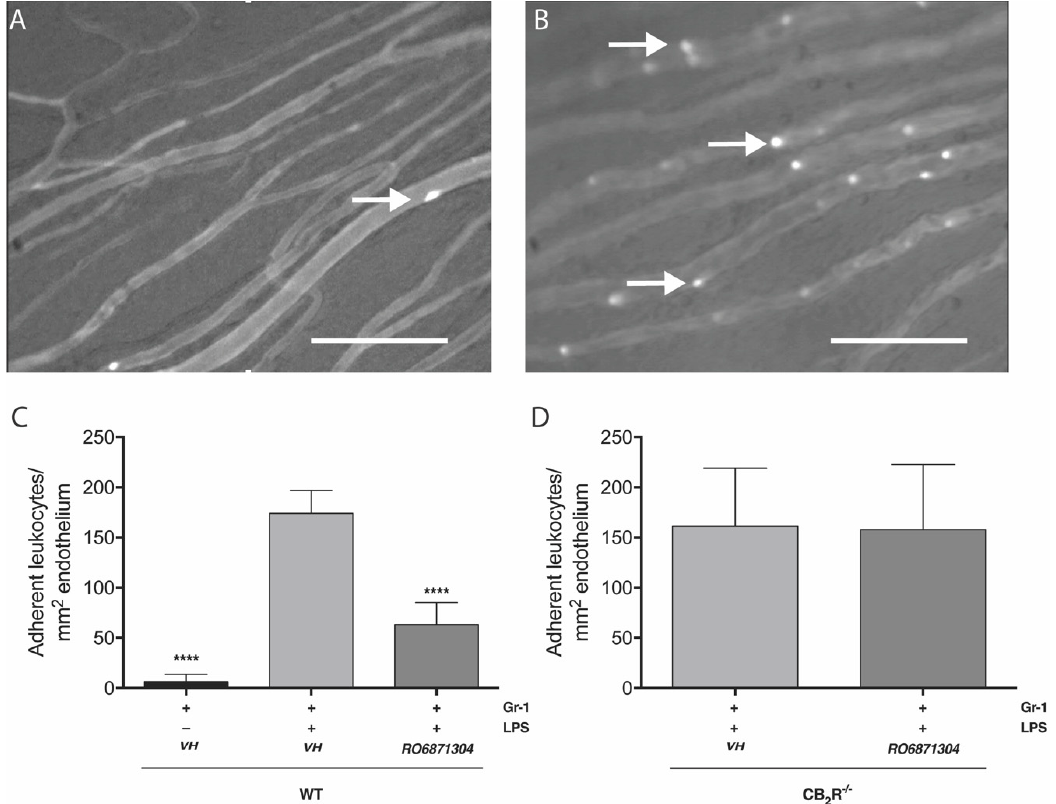
Figure 5. CB 2 R activation in neutrophil-depleted EIU mice with accompanying leukocyte adoptive transfer reduces leukocyte adhesion in the iridial microcirculation. Representative intravital microscopy (IVM) images of the iridial microcirculation of neutrophil-depleted mice showing the number of adoptively-transferred adherent leukocytes [calcein-acetoxymethyl ester (AM) pre-labeled] 6 h after intravitreal saline ( A ) or LPS ( B ). Arrows indicate adherent leukocytes. Scale bar = 100 µ m. ( C ) bar graph represents the mean number of adoptively-transferred WT leukocytes adherent to the iris microcirculation 6 h after EIU induction with LPS injection or saline control in neutrophil-depleted WT mice treated topically with vehicle (Tocrisolve) or RO6871304 (1.5% w / v ). n = 6-8; one-way ANOVA with Dunnett; **** p < 0.0001 compared to LPS + vehicle. ( D ) bar graph represents the mean number of adoptively-transferred WT leukocytes adherent to the iris microcirculation 6 h after EIU in neutrophil-depleted CB 2 R -/- mice treated topically with vehicle (Tocrisolve) or RO6871304. n = 6–8; two-tailed unpaired t-test; **** p > 0.05 compared to LPS + vehicle.